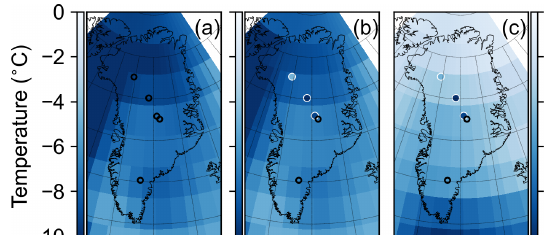
Figure 12. Spatial pattern of the abrupt cooling event into the Younger Dryas. Panel (a) shows results from experiment O8, as- similating all eight δ 18 O records, panel (b) shows results from ex- periment N3O5, assimilating all three δ 15 N-derived temperature records and the remaining five δ 18 O records (those that do not over- lap with the δ 15 N sites), and panel (c) shows results from experi- ment N3O5_BA, which is similar to the N3O5 experiment except that the prior ensemble is selected from the 1000 years surrounding the Bølling–Allerød warming. Unfilled black circles show locations of assimilated δ 18 O records, while filled circles with white outlines show locations of assimilated δ 15 N-derived temperature records. Filled circles in panels (b) and (c) show the δ 15 N-derived temper- ature values as reported by Buizert et al. (2014) on the same color scale as the rest of the panel. The temporal definition of this event is the same as defined in Buizert et al.